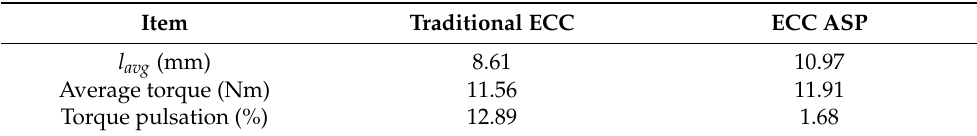
Figure 7. Average torque comparison of traditional ECC and ECC ASP. Table 3. Torque performance comparison through l avg .